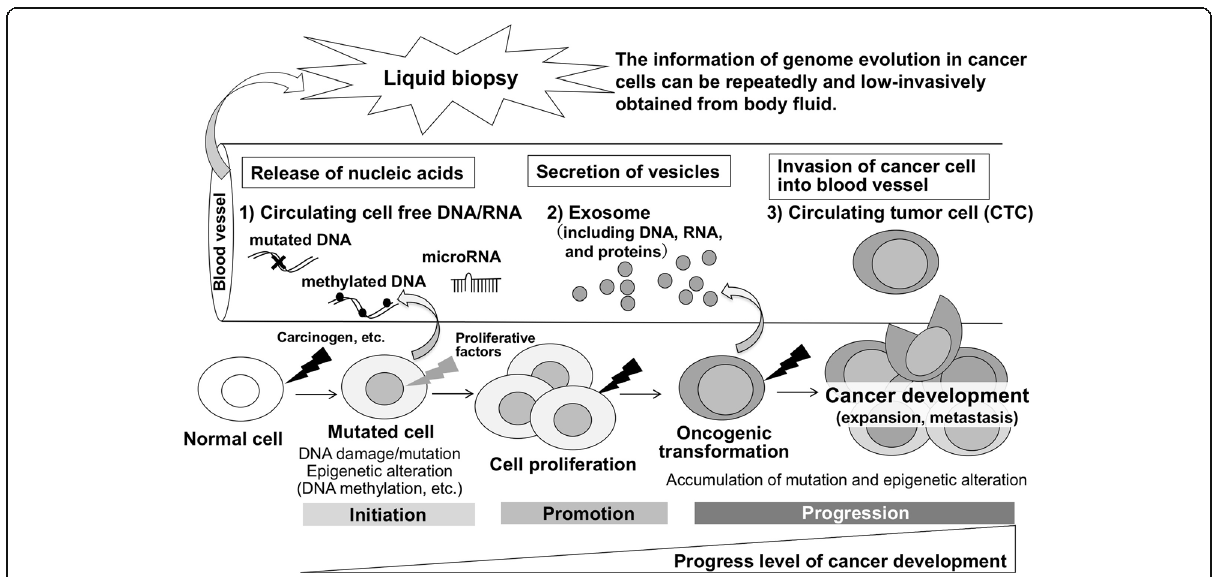
Fig. 3 Liquid biopsy and multistage